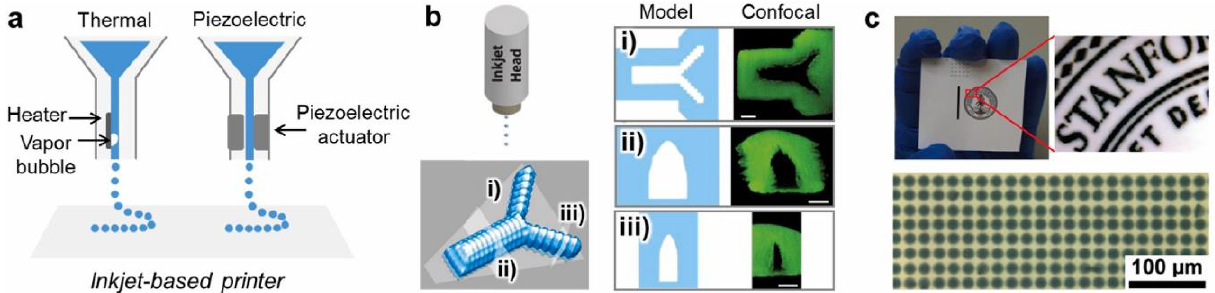
Figure 7. ( a ) Schematic of inkjet-based 3D printer. ( b ) Model and confocal slices at relative positions of a inkjet-based 3D printed microvasculature. Scale bar, 200 μm. ( c ) Micropatterned conducting hydrogel by inkjet-based 3D printing. Reprinted with permission from Elsevier [152].